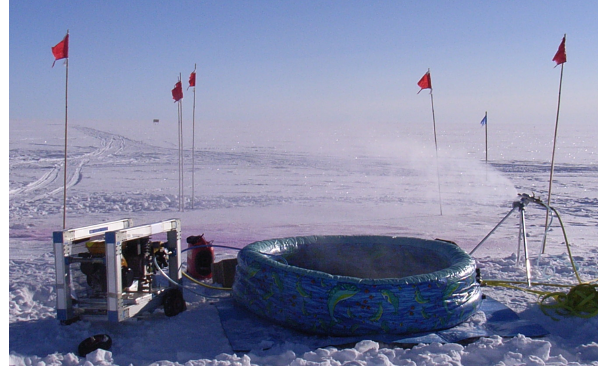
Figure 1. The production of the 2 H-labelled layer of snow at Sum- mit, 8 August 2007. From left to right the air compressor/water pump rack, the inflatable water container and the snow